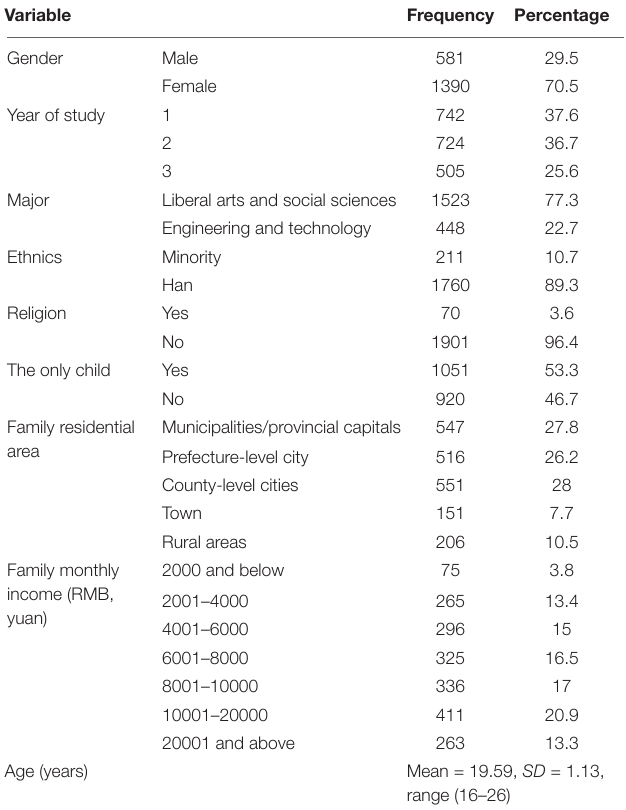
PsyCap (intrapersonal resource) in their relationship.